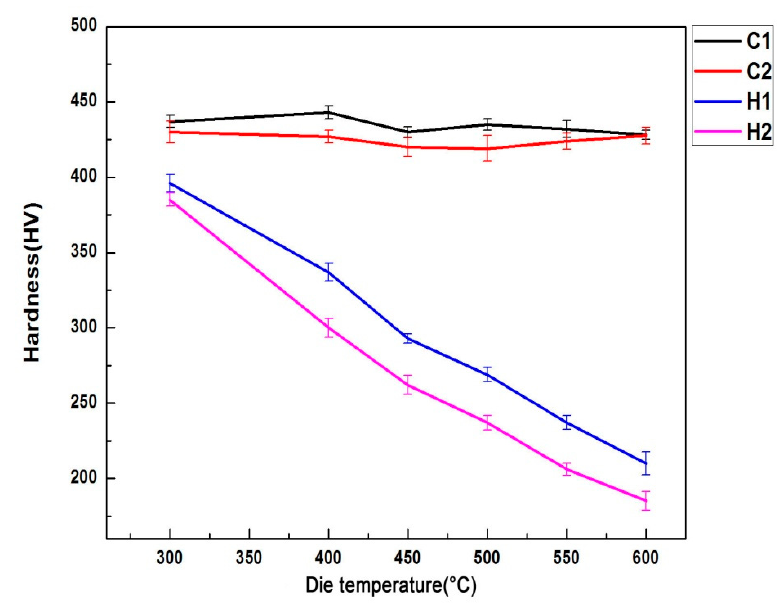
10 of 13 Figure 12. The area fraction under different tool temperatures of: ( a ) martensite, ( b ) bainite, and ( c ) ferrite. 3.2. Performance Results Figure 13 displays the hardness measurements as the die temperature increased. The hardness of C1 and C2 could reach 445 and 428 HV, respectively. When the die temperature rose from 300 to 600 °C, the hardness at position H1 decreased from 397 to 210 HV, and the hardness at position H2 decreased from 382 HV to 180 HV. The reason behind this was the introduction of some volume fraction of bainite into the as-quenched microstructure. The hardness of the bottom (C1 and H1) of the part was higher than that of the side wall (C2 and H2). This was because the bottom of the part first contacted the die, as discussed earlier, which caused a high martensite content and high